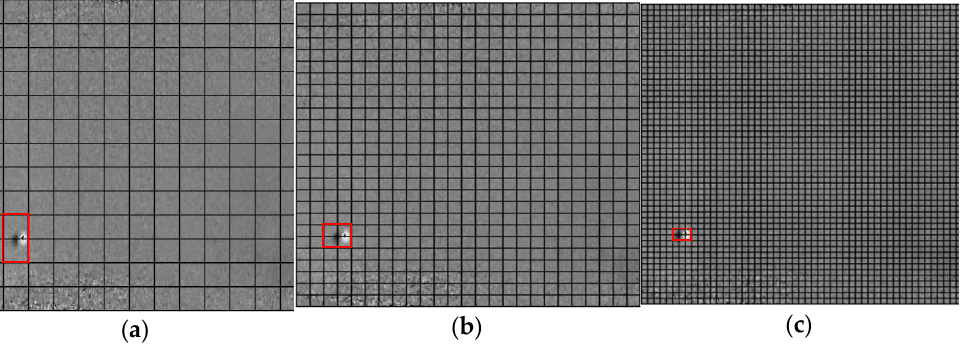
Figure 4. Visualization of different grid sizes: ( a ) Large scale (32 × 32), ( b ) Medium scale (16 × 16), and ( c ) Small scale (8 × 8).